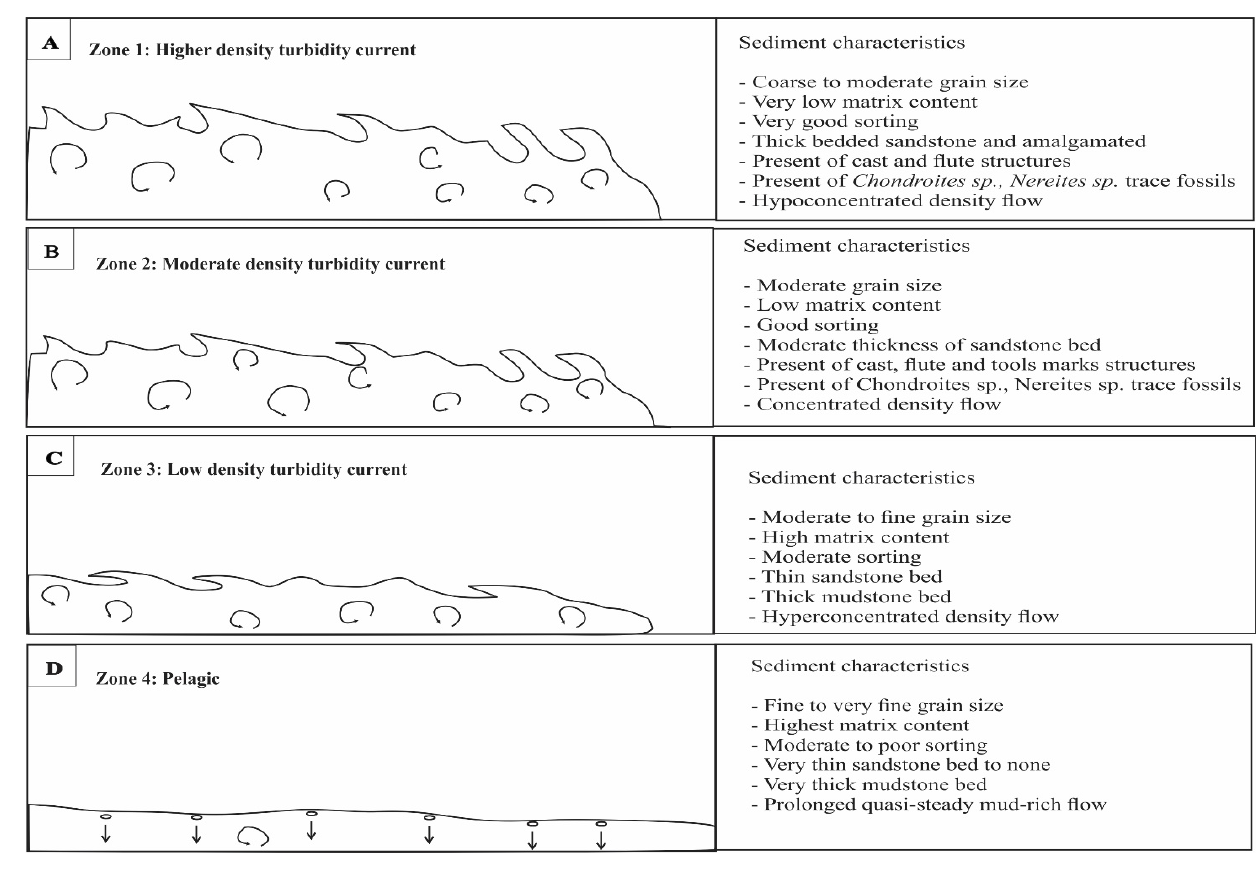
Figure 10. Summary of sediment transport behaviors and sediment characteristics of each zone es- tablished in this research. ( a ) Highest turbidity current related to the proximal zone 1 in the inner established in this research. ( A ) Highest turbidity current related to the proximal zone 1 in the inner fan area. ( b ) Moderate turbidity current related to the mid fan of the zone 2 area. ( c ) Low turbidity fan area. ( B ) Moderate turbidity current related to the mid fan of the zone 2 area. ( C ) Low turbidity current illustrated by zone 3 in the outer fan area. ( d ) The pelagic deposited in the basin plain area. current illustrated by zone 3 in the outer fan area. ( D ) The pelagic deposited in the basin plain area. Zone 3 is the area of the distal lobe located in the outer fan of the deep-water